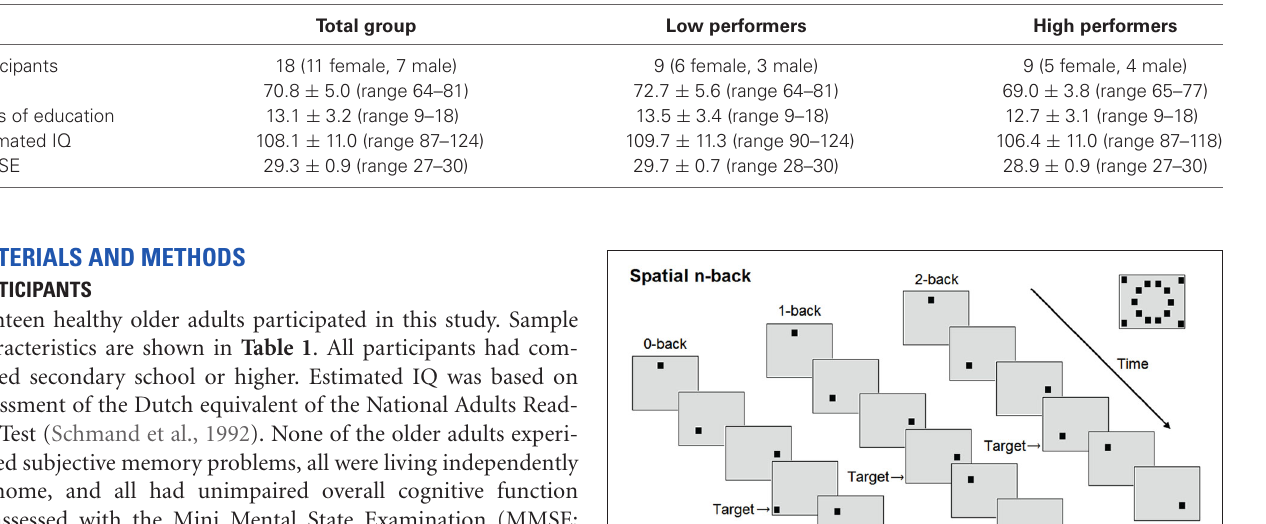
Table 1 | Sample characteristics .